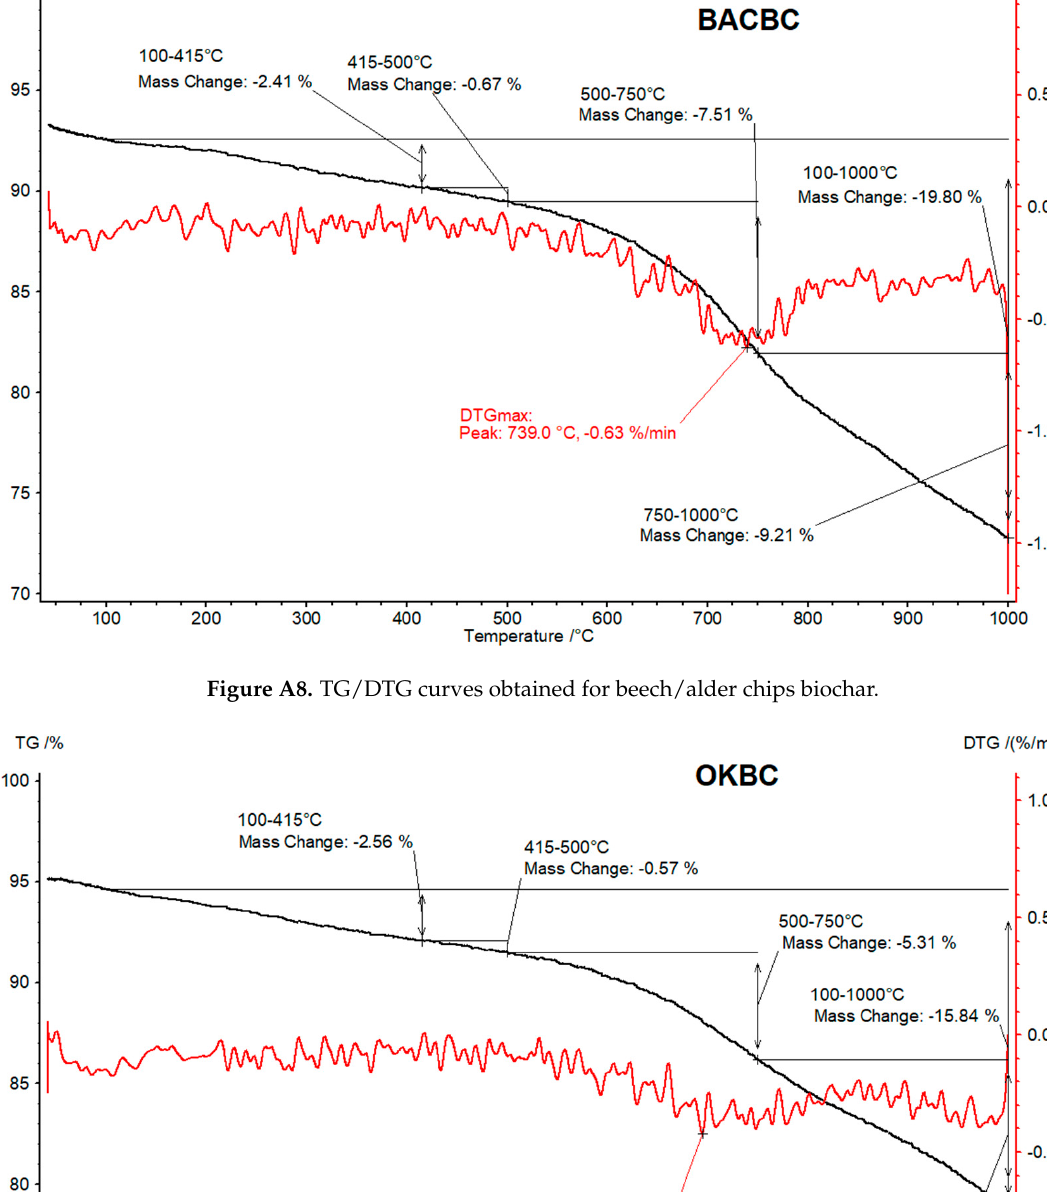
Figure A7 . TG/DTG curves obtained for pine sawdust biochar.